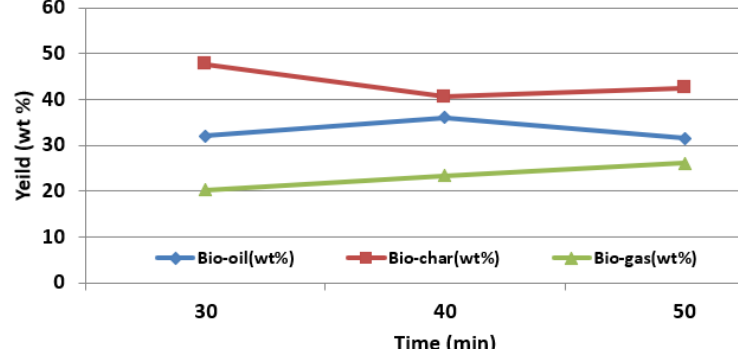
Figure 8: Bio-oil yield for conventional heating process in different temperature against